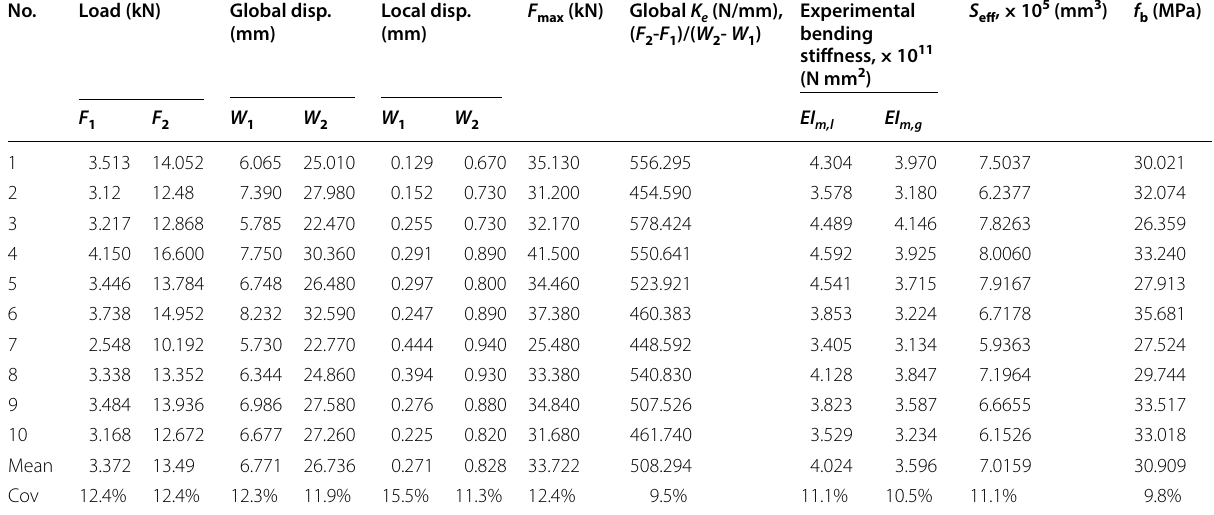
Table 6 Experimental results for 3-layer CLT bending panels (CL3/105/3300) No.